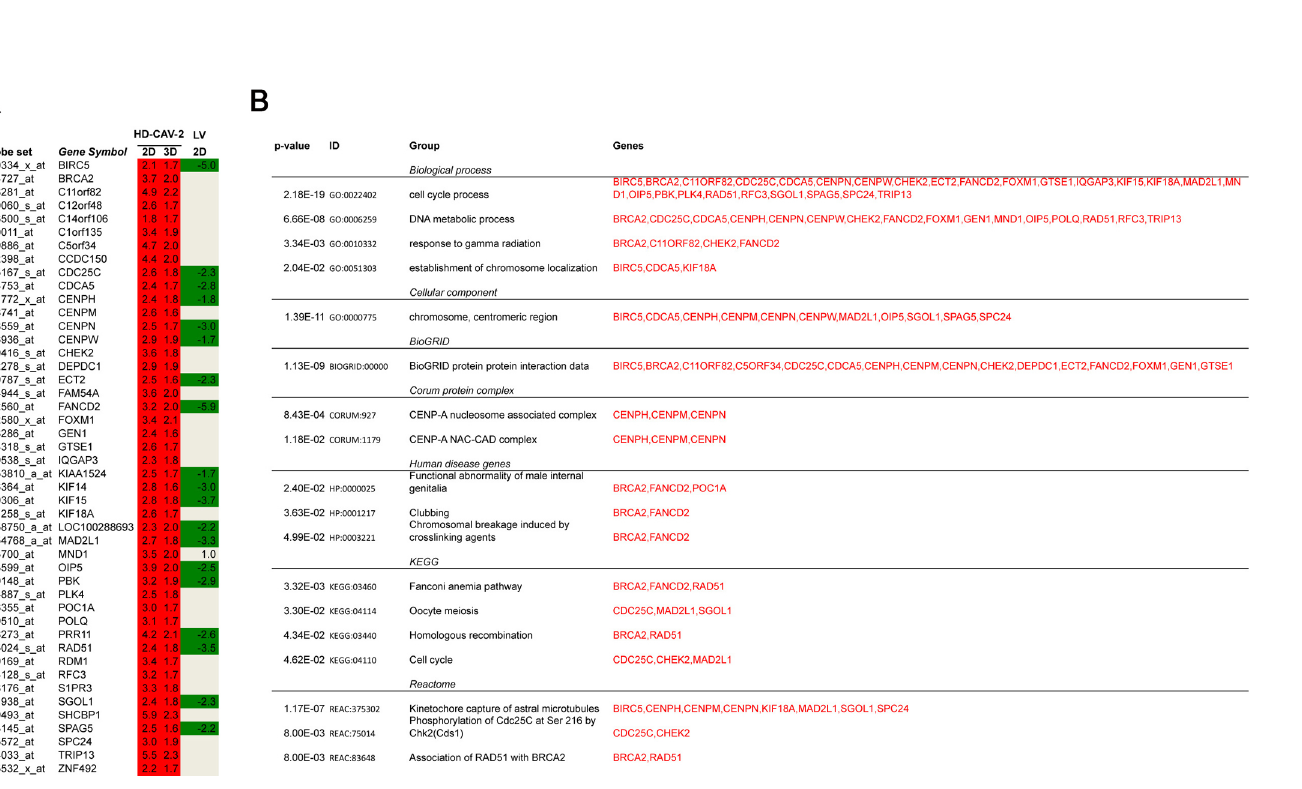
Fig 5. Comparative analysis of the response of 2D and 3D cultured hmNPCs to HD-CAV-2. In silico comparison of transcriptome data obtained from 2D hmNPCs transduced at an MOI of 1000 with HD-CAV-2 or with LV, with data obtained from HD-CAV-2 neurospheres. A) Comparative analysis revealed that 46 probes were found modulated in both 2D and 3D hmNPCs transduced with HD-CAV-2 and with the same sign, while a completely non-overlapping pattern is observed in LV-cells. B) g:Profiler gGOSt set as significant only, hierarchical sorting, and hierarchical filtering best per parent group (strong), was used to classify the genes commonly modulated in 2D and 3D culture conditions by HD-CAV-2. The analysis underlines the significant modulation of DNA damage response-, centromeric and microtubule metabolism-related probes. In red, upregulated probes, in green, downregulated, and in grey, probes with unmodified expression with respect to